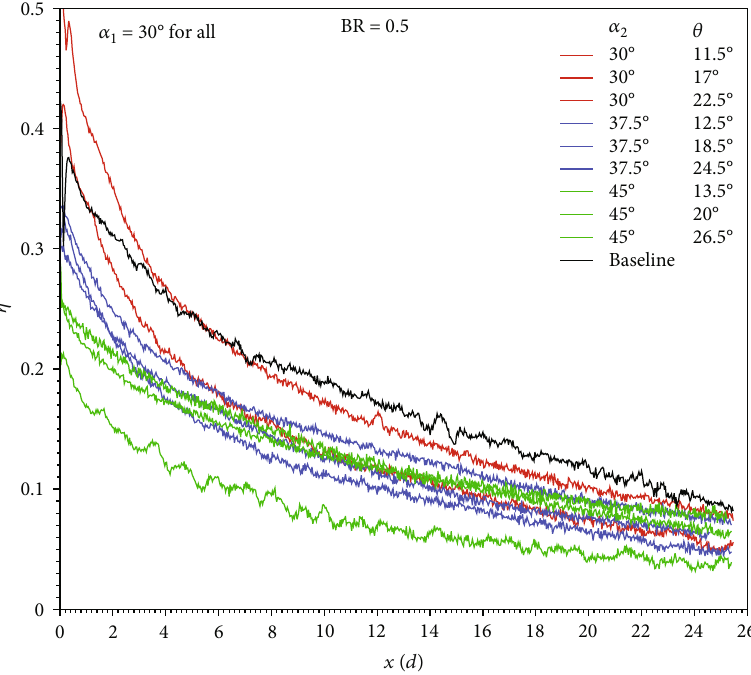
Figure 25: Comparison of streamwise (laterally averaged) fi lm e ff ectiveness variations for all geometries at BR = 0 : 5